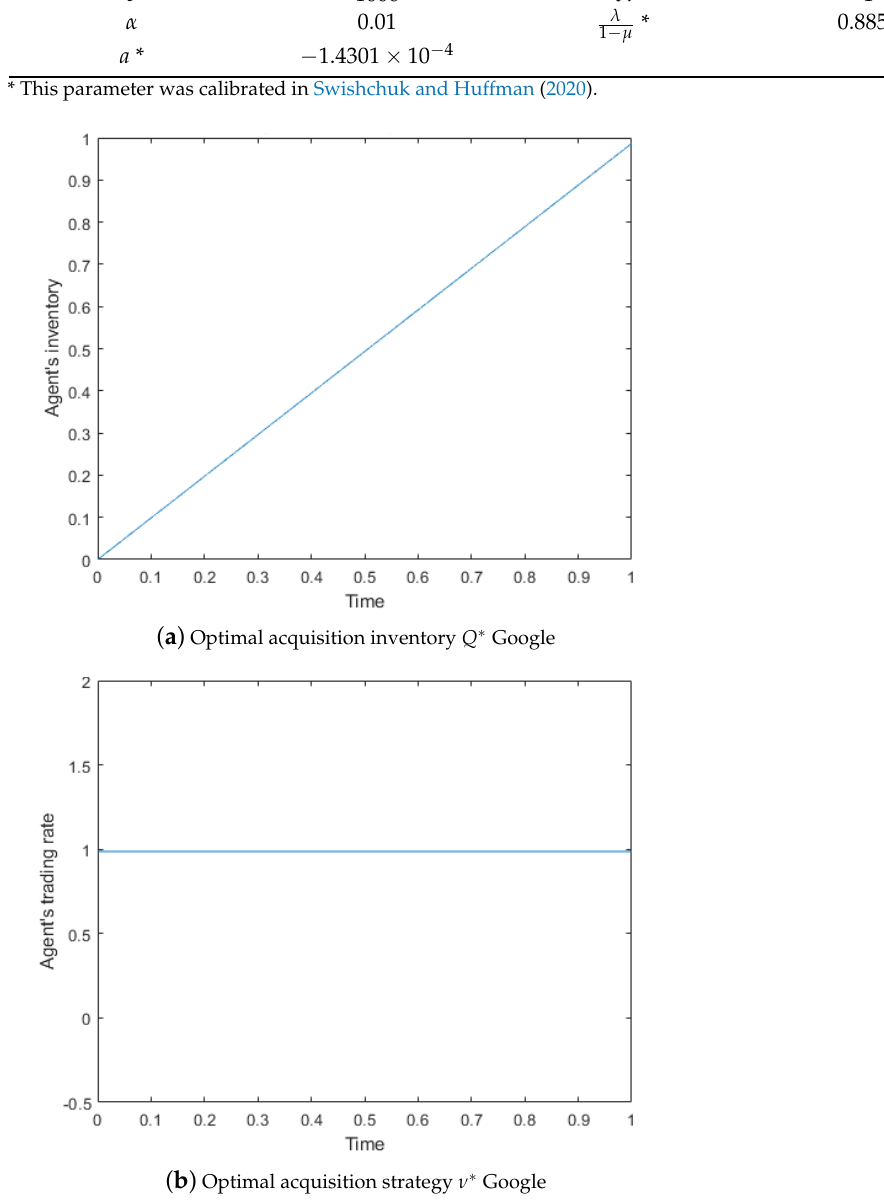
Figure 7. Optimal acquisition inventory and optimal acquisition strategy for Google stocks. ( a ) the inventory calculated with Equation (56), using the parameters in Table 7. ( b ) the optimal acquisition value calculated with Equation (57), using the parameters in Table